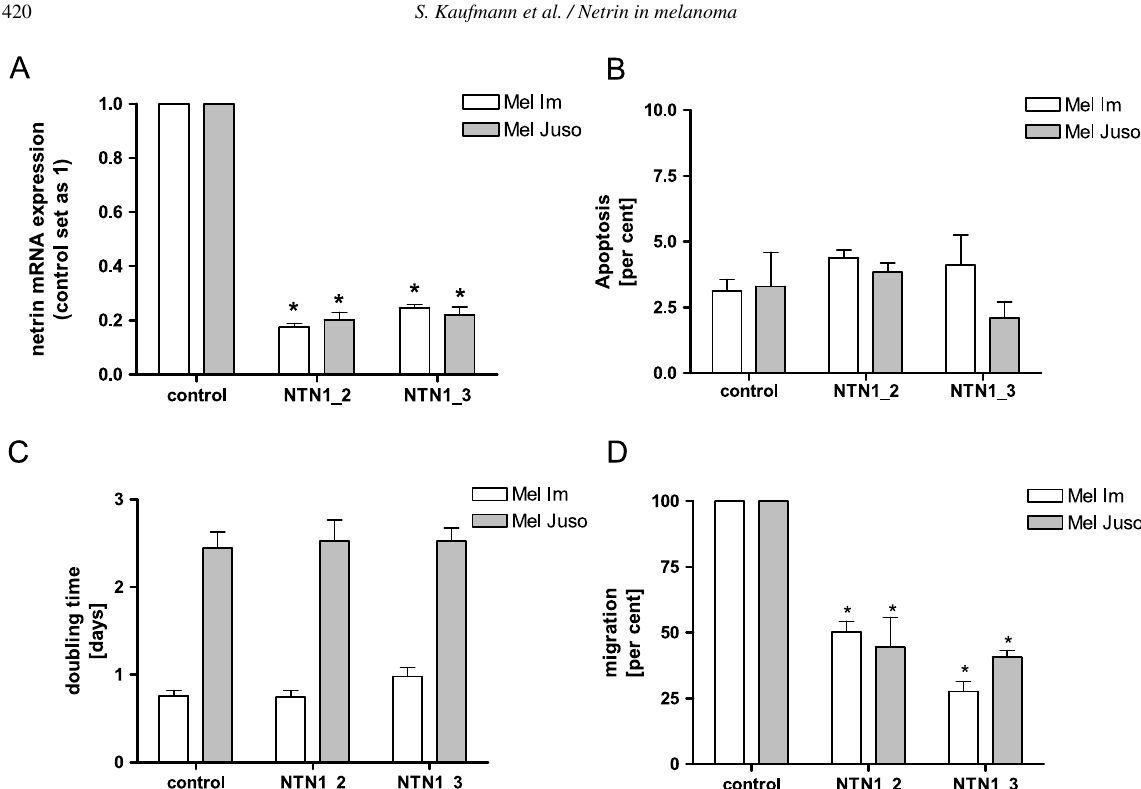
Fig. 4. Functional impact of Netrin-1 on melanoma cells. Mel Im and Mel Juso cells were transfected with two independent siRNAs against Netrin-1 mRNA (NTN1 2, NTN1 3) or control siRNA. (A) Quantitative real time RT-PCR analysis of Netrin-1 mRNA expression revealed strong suppression by both Netrin siRNAs. (B, C) Apoptosis (B) and proliferation (C) assays did not reveal significant differences comparing Netrin siRNA treated cells with control treated Mel Im or Mel Juso cells. (D) Influence of repression of Netrin-1 expression on migration of Mel Im or Mel Juso cells was determined in the Boyden chamber model. Here, significant reduction was observed. All experiments were repeated three times, bars display mean + SD, statistical analysis was performed using a Student’s unpaired t -test. (* p < 0 .